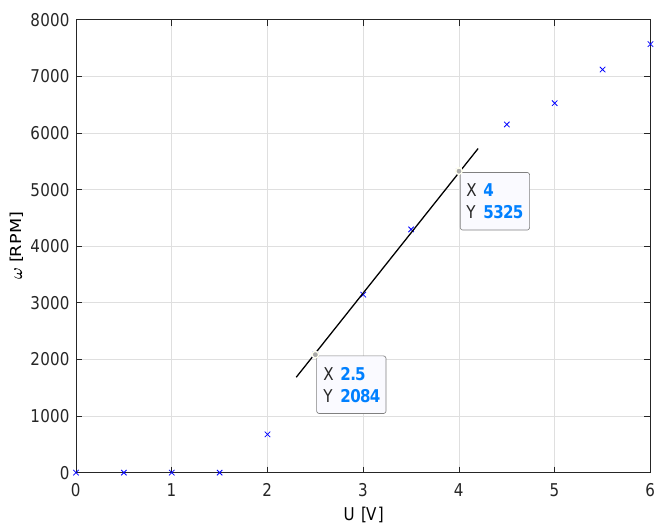
Figure 5. Static input-output characteristics.